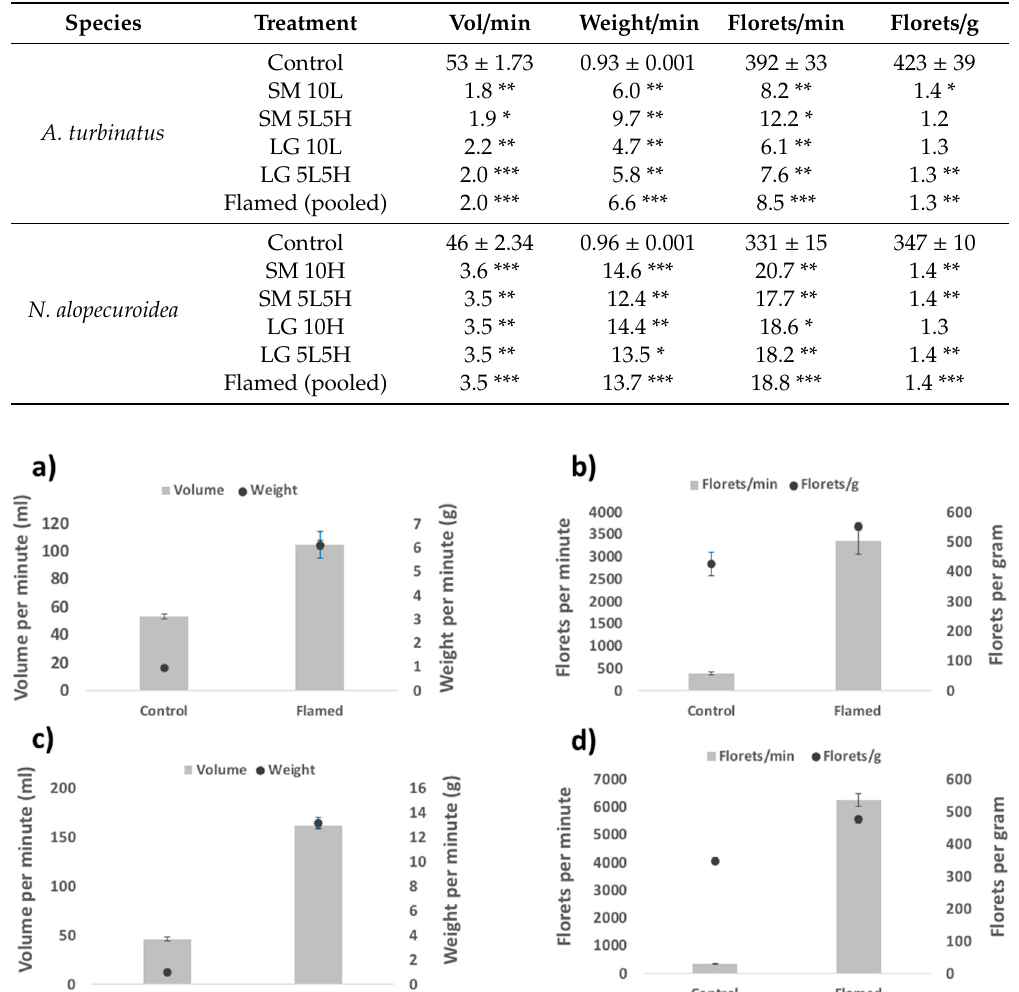
Table 1. Flowability data showing the fold-increase in volume per minute, weight per minute, and number of florets per minute passed through the custom-built mechanised seeder compared to the control. The number of florets per gram is also provided. Asterisks “*”, “**”, and “***” represent significance levels 0.05, 0.01, 0.001, respectively. For example, “(1.8**)” indicates that the treatment resulted in a 1.8-fold improvement on the control and that this increase was significant ( p < 0.01). The mean ± standard error values for the control have been provided.